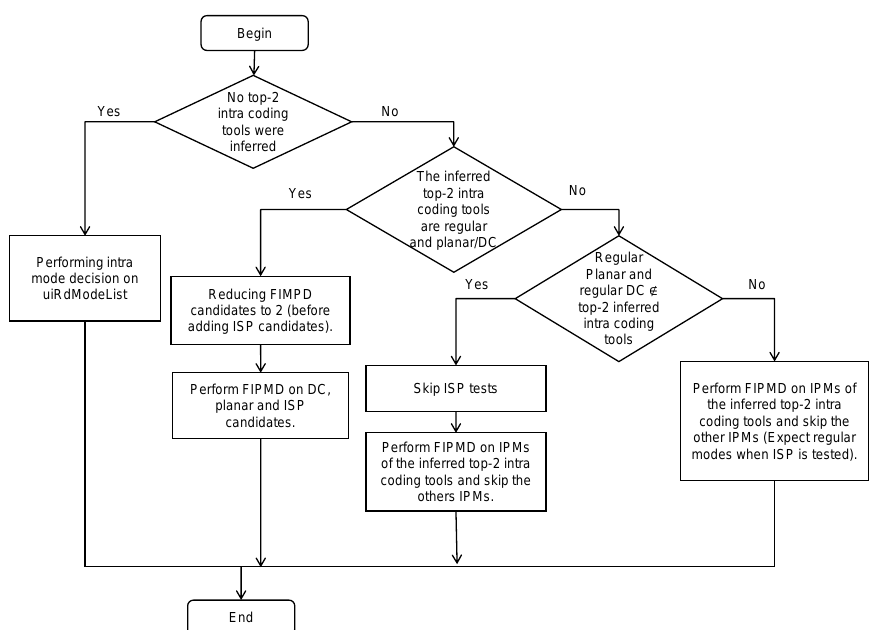
Figure 6. Process of integrating the MTL CNN under VTM10.2 to skip unlikely